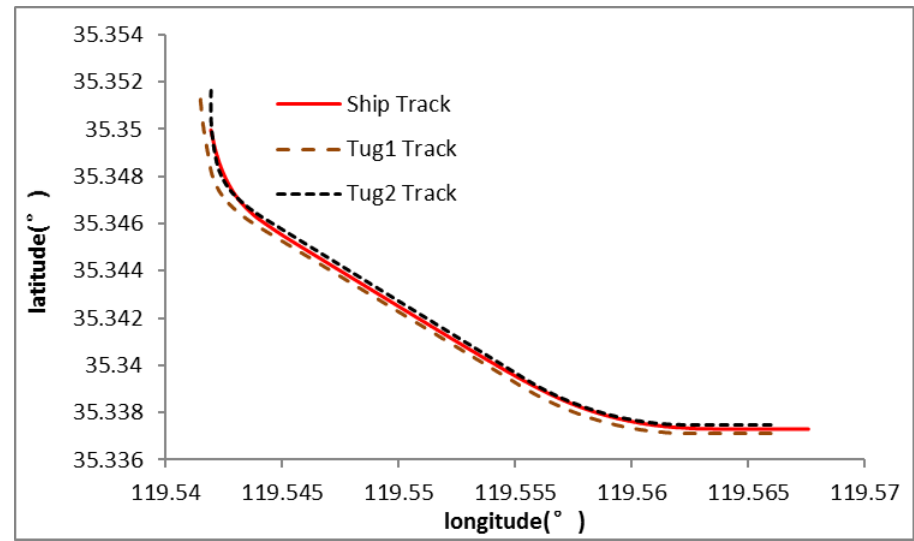
Figure 16. Motion process diagram of multi-tug-assisted ship towing.